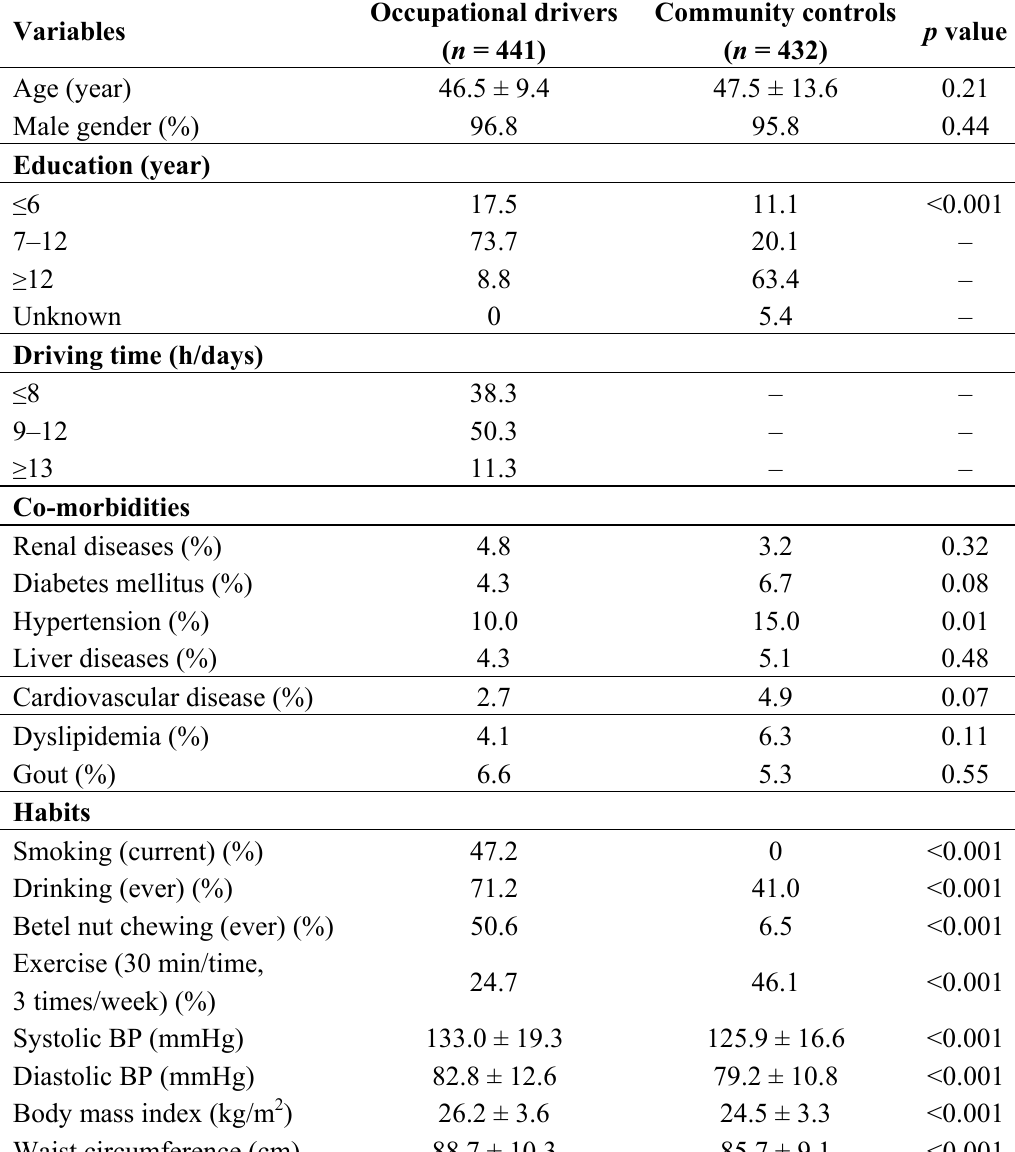
Table 1. Comparison of baseline characteristics between occupational drivers and community